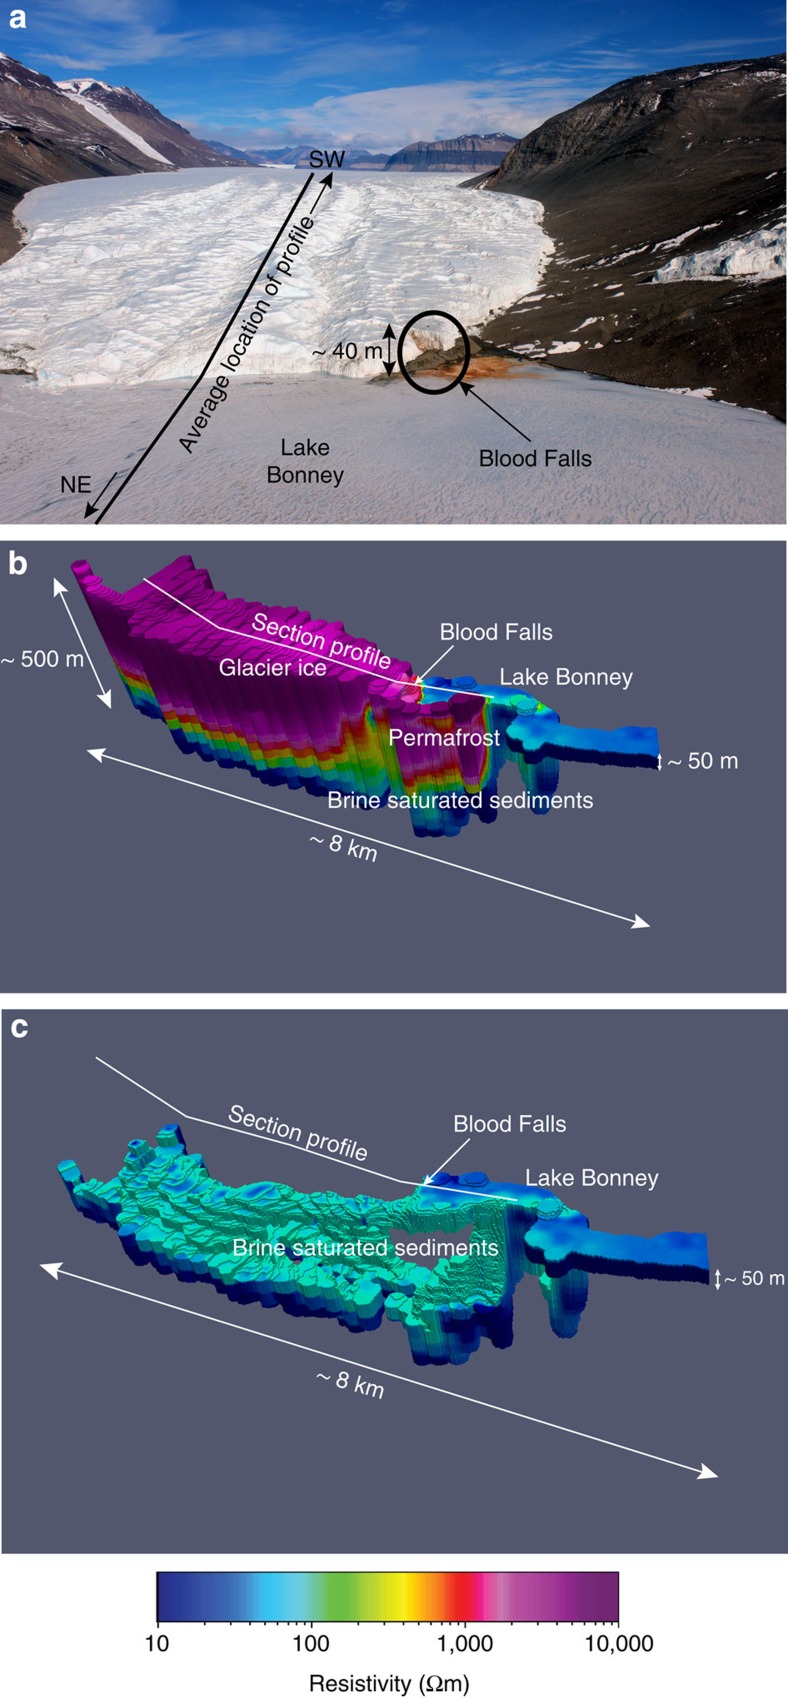
Resistivity maps from the Taylor Glacier and Bonney Basin survey.(a) Photograph of the lower 2 km of Taylor Glacier showing its contact with Lake Bonney. Blood Falls is marked by the orange staining of ice caused by the release and oxidation of subglacial brine. (b) 3D presentation showing highly resistive glacier ice and permafrost with conductive subglacial brine. (c) 3D image of the Taylor Glacier with resistivities above 100 Ωm removed to show the spatial extent of conductive brine-saturated sediments below glacial ice.